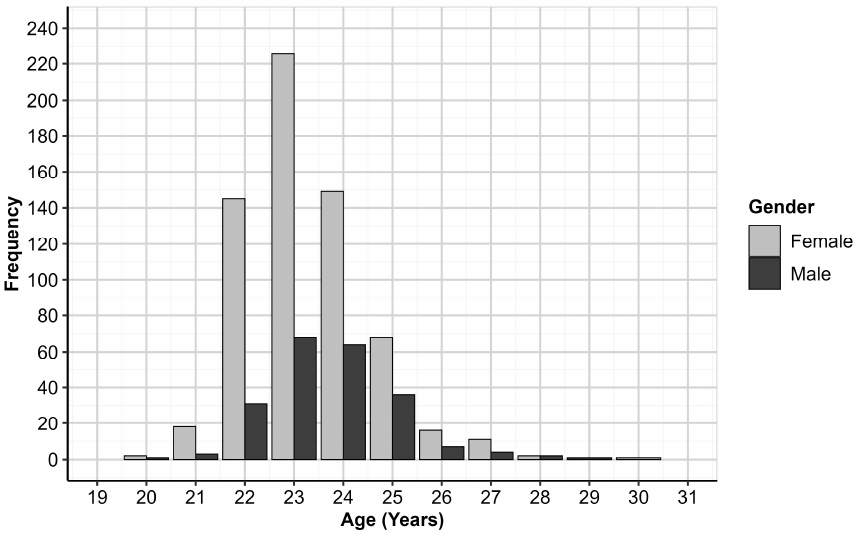
Figure 1. Distribution of Age by Gender.